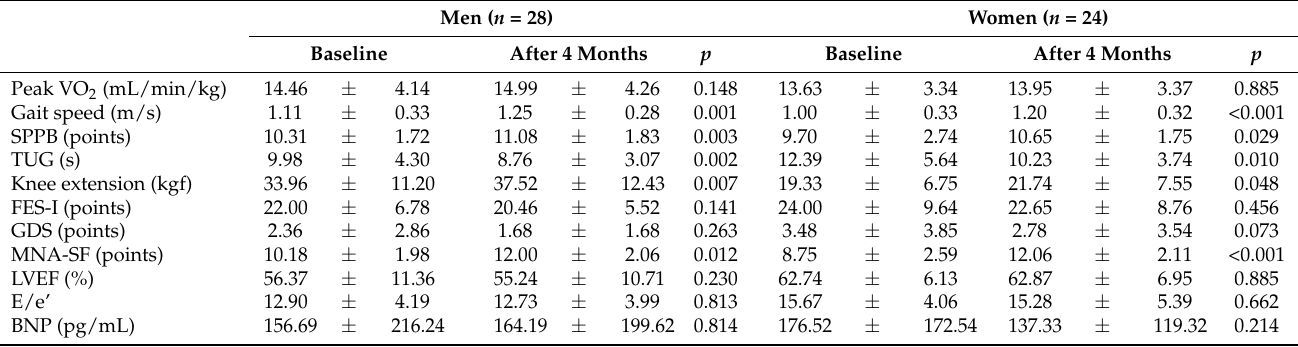
Table 3. BEAR effects in participants according to